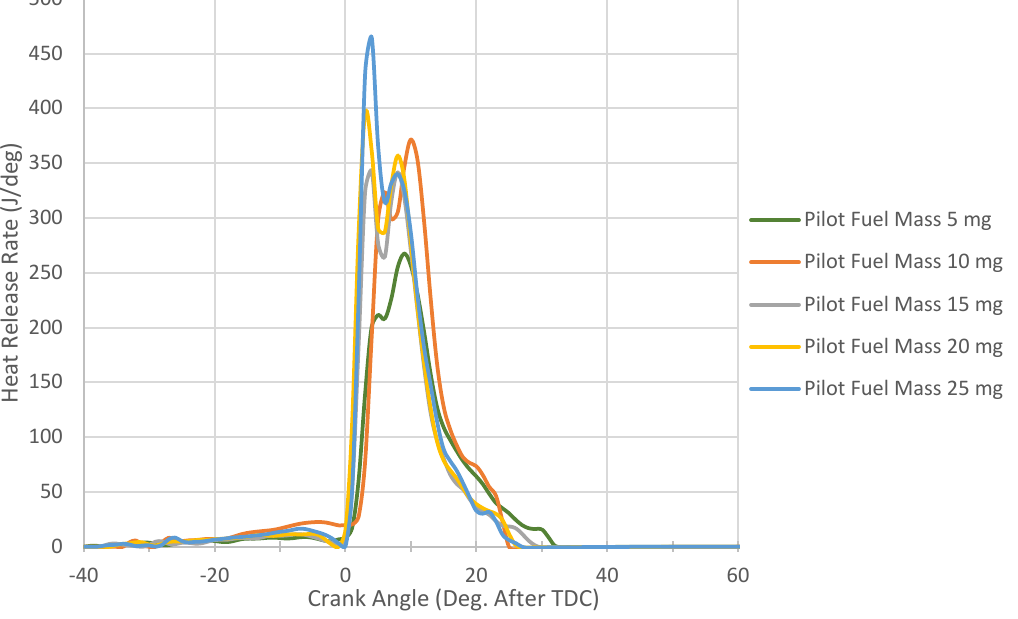
Figure 4. Heat release rate versus crank angle (SOI = 10° BTDC).